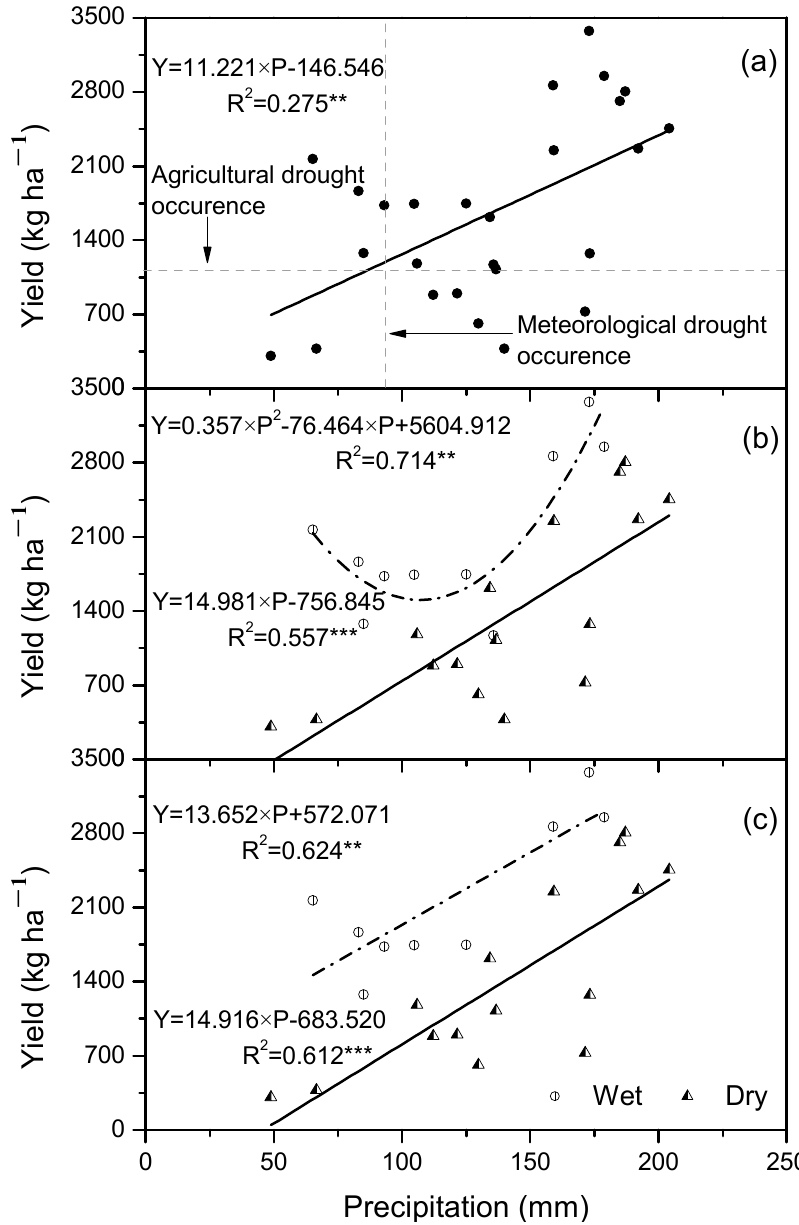
Figure 1. The relationship between spring wheat yield and precipitation during spring wheat growing season. ( a ) The relationship between yield and precipitation without taken soil conditions into consideration, ( b ) The different relationships between yield and precipitation with taken soil conditions into consideration, ( c ) The different liner relationships between yield and precipitation with taken soil conditions into consideration. Soil conditions was classified into two groups by the amount of soil water content at planting of greater or less than 100 mm. *** and ** indicate significance levels of 0.001 and 0.01. The ANOVA analysis of the regression equations under different soil conditions are shown in Table S1.